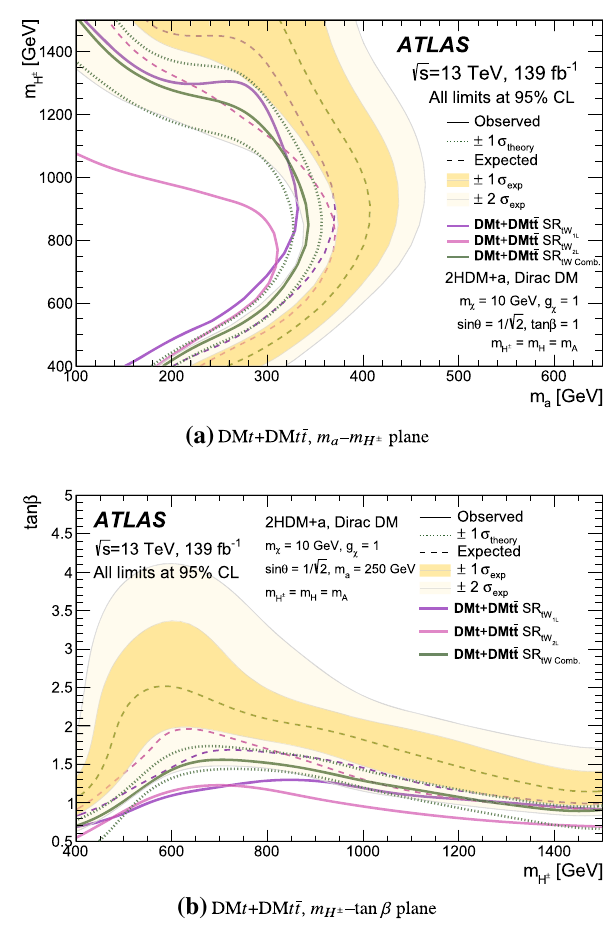
Fig. 14 The expected and observed exclusion contours as a function of ( m a , m H ± ) (top) and ( m H ± , tan β) (bottom), assuming DM t ¯ t and DM t contributions,fortheindividualtW 1L (purpleline)andtW 2L (pink line)analysischannels,andfortheirstatisticalcombination(greenline). Experimental and theoretical systematic uncertainties, as described in Sect. 6, are applied to background and signal samples and illustrated by the ± 1 standard-deviation and ± 2 standard-deviation yellow bands and the green dotted contour lines, respectively, for the statistical com-